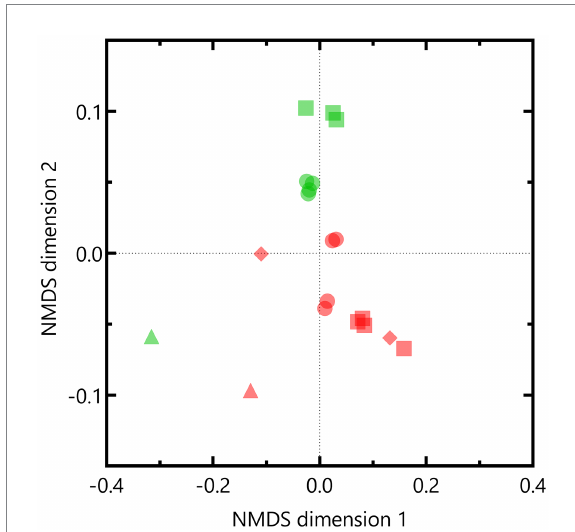
FIGURE 7 Non-metric multidimensional scaling (NMDS) based on weighted Unifrac distances of the OTUs of the bacterial community in the Boom clay borehole water (red) and Harpur Hill sediment (green) at initial pH 9 (circles), pH 10.5 (squares) and pH 12.5 (diamonds). The initial community is presented as